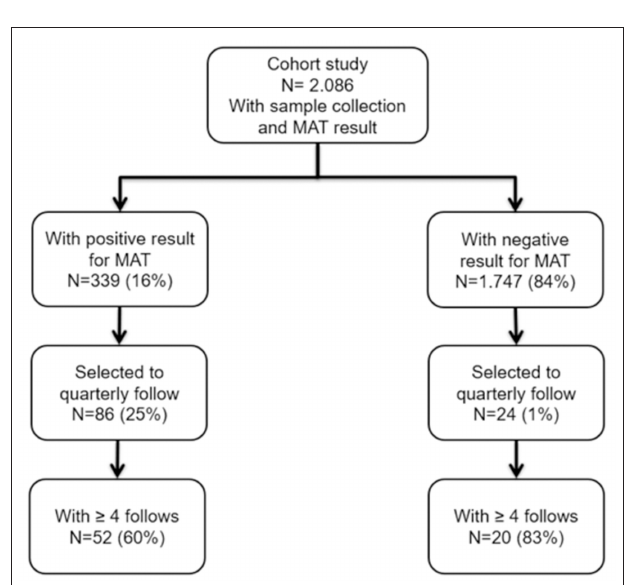
FIGURE 2 | Flowchart of the study participants